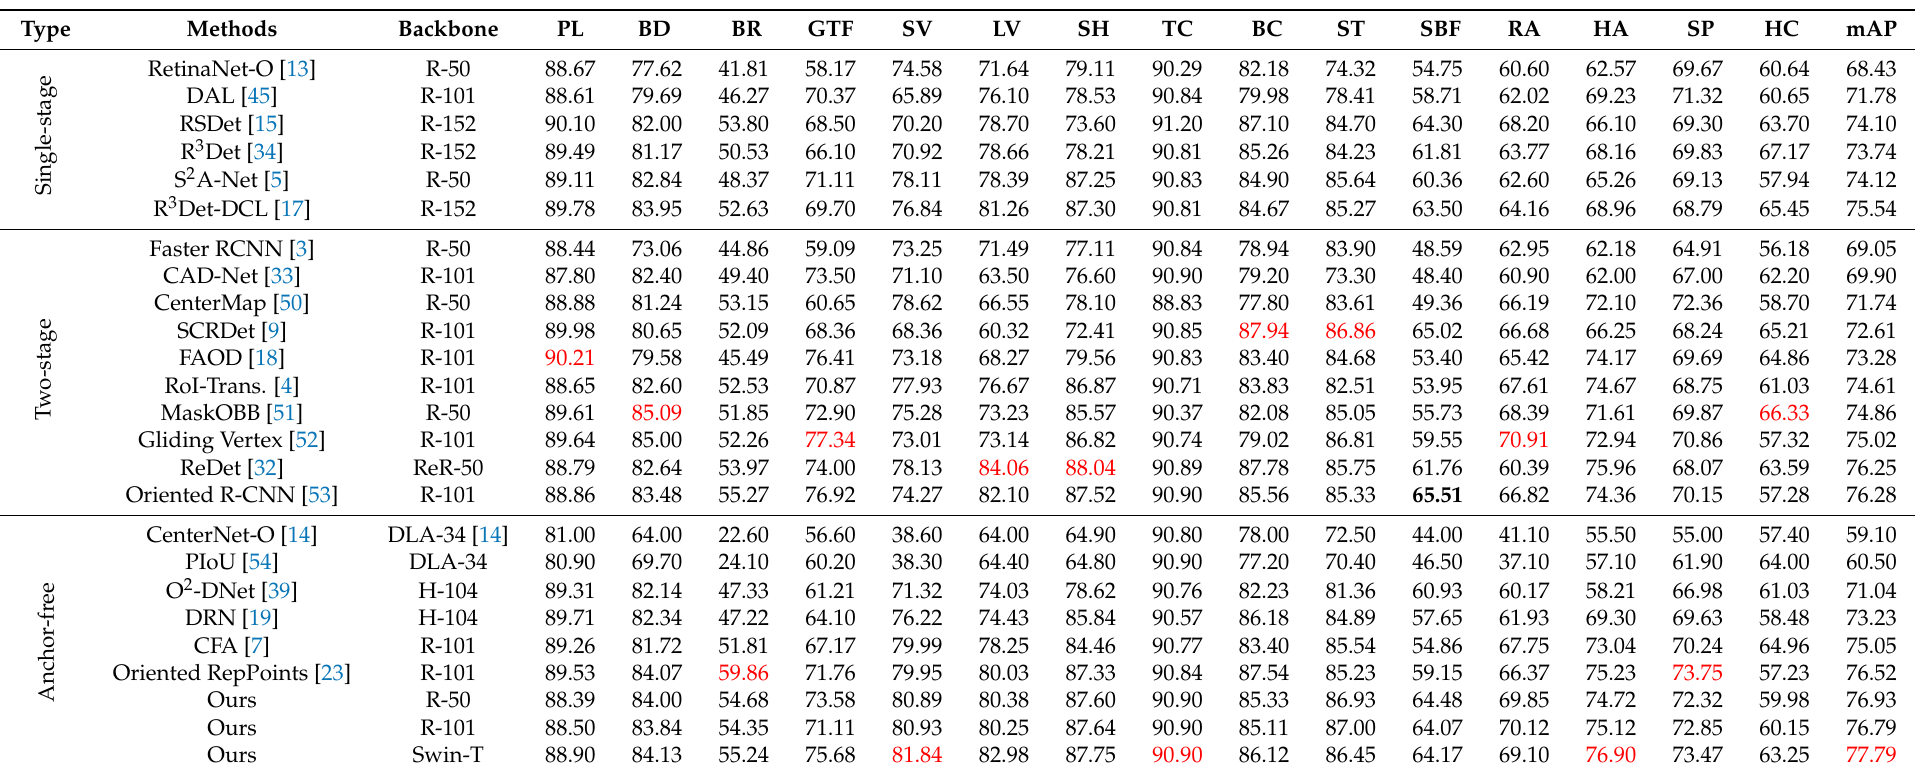
Table 1. Comparisons with state-of-the-art methods on the DOTA dataset. All the reported results were performed on the single-scale DOTA. The results with red color denote the best results in each